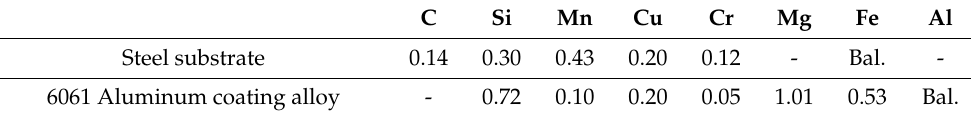
Table 1. Chemical composition of carbon steel substrate and 6061 aluminum coating alloy, wt. %.